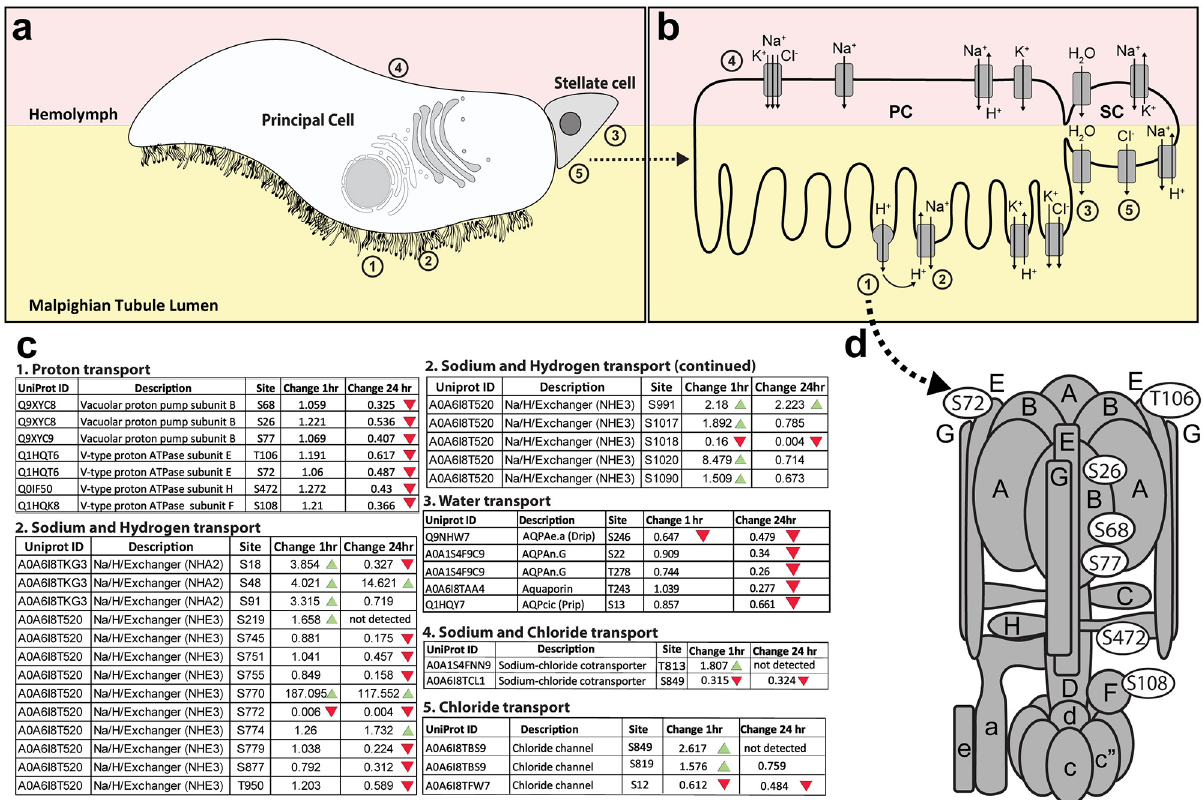
Fig 2. Changes in phosphorylation of ion channels, pumps, and aquaporins. a. Illustration of the two major cell types in the Malpighian tubule epithelium: principal cells (PCs) are larger and have an apical brush border of microvilli filled with mitochondria containing V-type H + ATPase pumps and other ion transporters; stellate cells (SCs) are smaller and participate in Cl - and water transport. Numbers correspond to different regions where particular transport mechanisms occur, and correspond to the numbers in parts b and c. b. Ion channels and aquaporins associated with transcellular transport are illustrated. c. Specific amino acid residues on proteins with phosphorylation changes of at least 1.5-fold between unfed and blood-fed mosquitoes are shown in white ovals. The numbers in the figure correspond to tables where proteins with related functions are grouped. Tables contain the Uniprot IDs for each protein as well as the fold-change in phosphorylation of each residue between unfed and either 1hr PBM or 24hr PBM mosquitoes. Green arrows represent an increase of at least 1.5-fold in phosphorylation at the specified residue between unfed and PBM mosquitoes, and red arrows represent a decrease of at least 1.5-fold in phosphorylation at the specified residue between unfed and PBM mosquitoes. Numbers of each table correspond to transport mechanisms illustrated in parts a and b. d. V-type H + ATPase model adapted from Zhao et al (2015) and Beyenbach & Piermarini (2011) showing the location of subunits with differential phosphorylation. Subunits are shown in gray, and specific phosphorylated residues are denoted with white ovals.